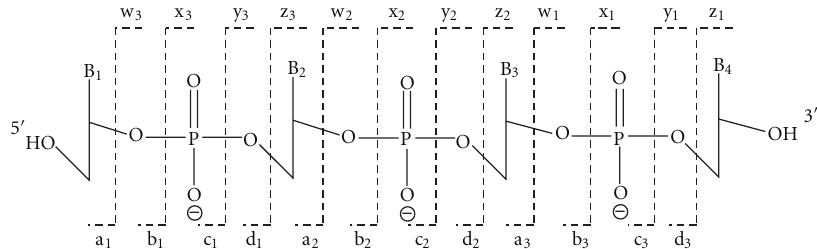
Figure 20: Nomenclature of the fragment ions produced by the CID of